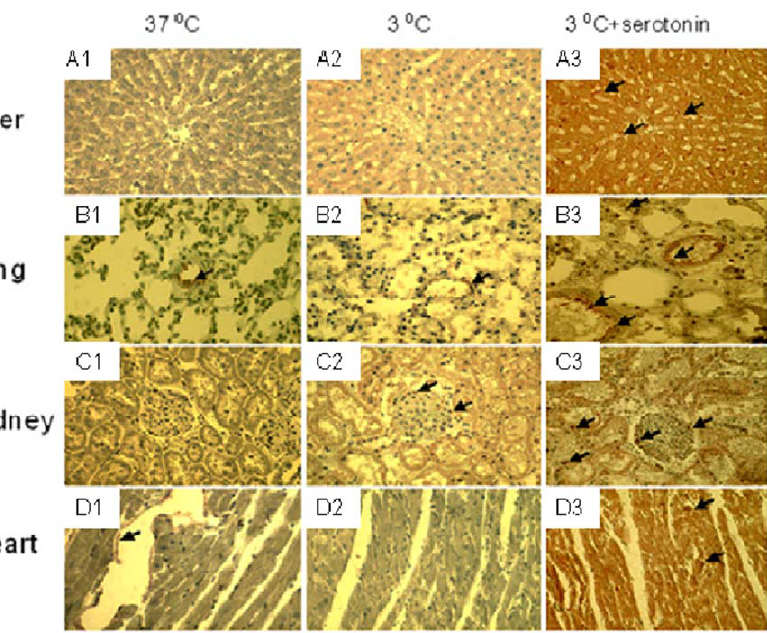
Figure 5. Localization of serotonin induced increase in cystathionine- b -synthase (CBS) expression during cold storage. Preincubation of slices with serotonin (90 m M, 30 min) and the subsequent 24 hr of hypothermic storage (3 u C) causes substantial increase in the expression of CBS (A3-D3) compared to freshly processed control tissue (37 u C, A1-D1) or nontreated cooled controls (3 u C, A2-D2). Rat tissues were cut in slices in isotonic PBS and subjected to 24 h at 3 u C, followed by processing for analysis by fixation. CBS is represented by brown staining and indicated by arrows. Magnification 40 6 .